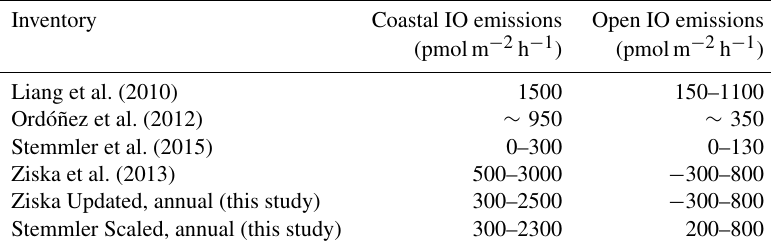
Table 1. Tropical coastal and open Indian Ocean (IO: 40–90 ◦ E) annual mean emissions for different bromoform emission inventories. Values are given as fixed number, approximation, or range (representing spatial variation) depending on the design of the inventory.